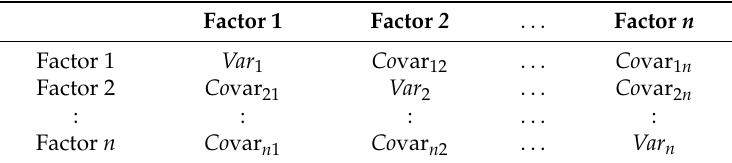
Table 2. The variance–covariance matrix of factors.